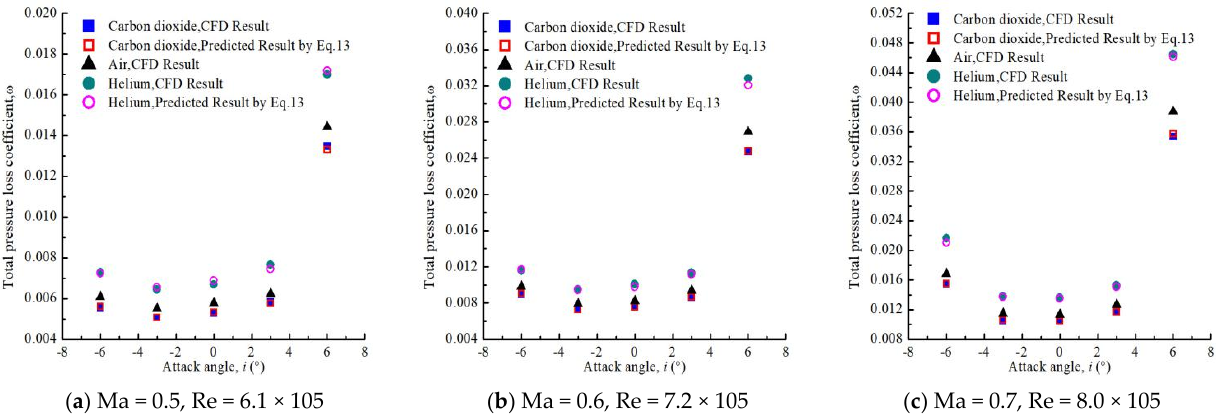
Figure 7. The correlation among coefficient of total pressure loss and Reynolds number, Mach number, specific heat ratio.